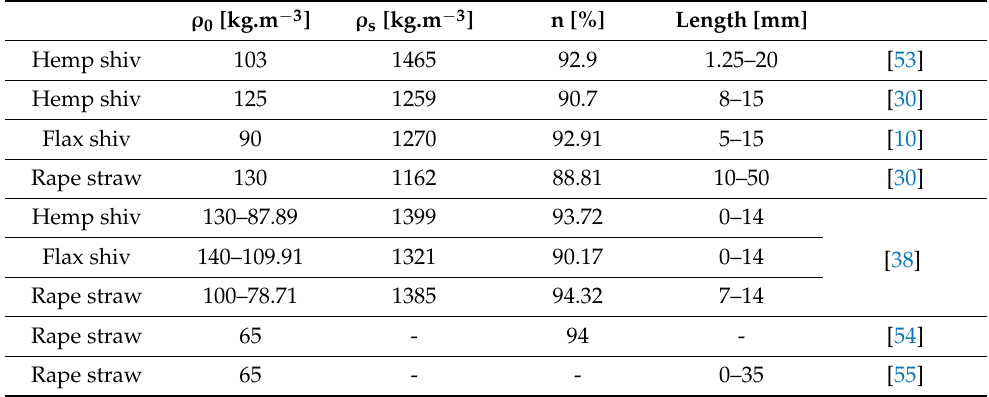
Table 5. Bulkdensity ( ρ 0 ), real density ( ρ s), porosity (n) and length of aggregates from the